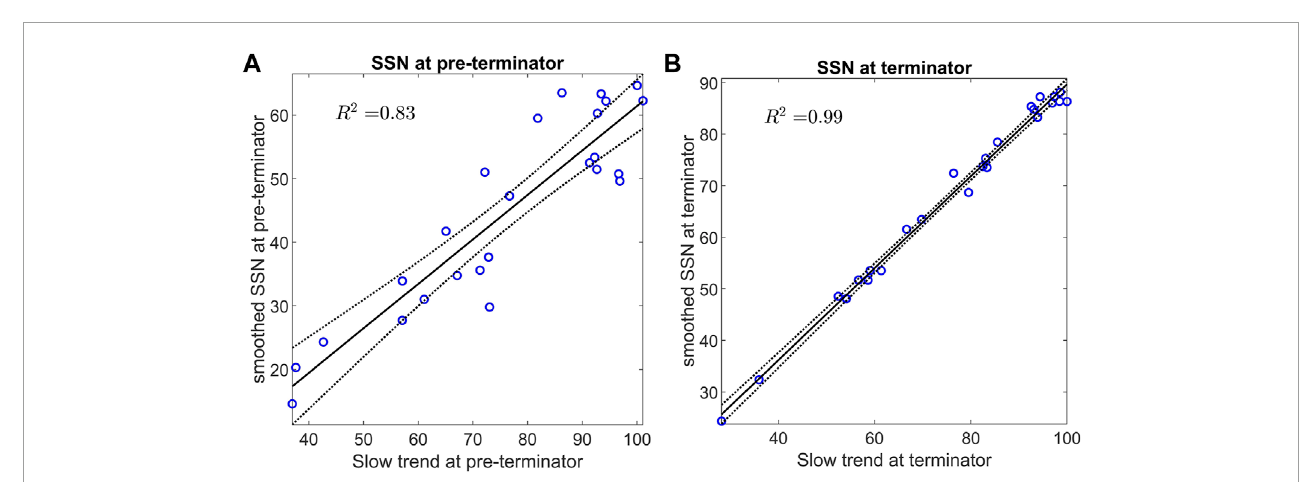
FIGURE 4 The slow trend predicts the smoothed sunspot number at the switch-off and switch-on of activity. Linear regression of 13 month smoothed sunspot number on its slow (40 year rlowess) trend (left) at the pre-terminators and (right) at the terminators. Best fit line (solid black line) and 95% confidence bounds (dashed black lines) are overplotted on the data (blue circles). The R 2 of each fit is indicated.